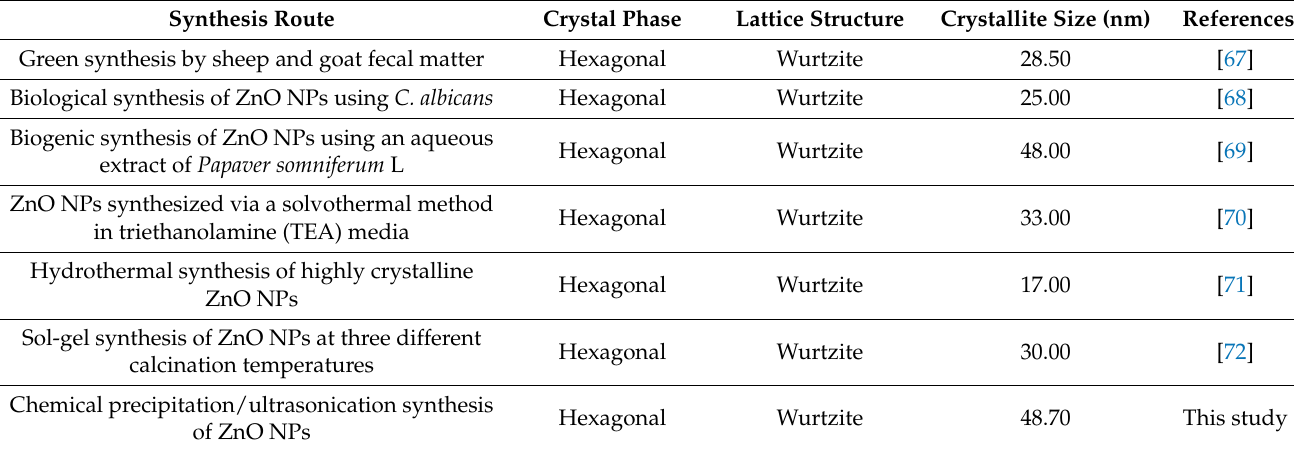
Table 2. Crystallinity of synthesized ZnO NPs based on the synthesis route and structure compared with those in the